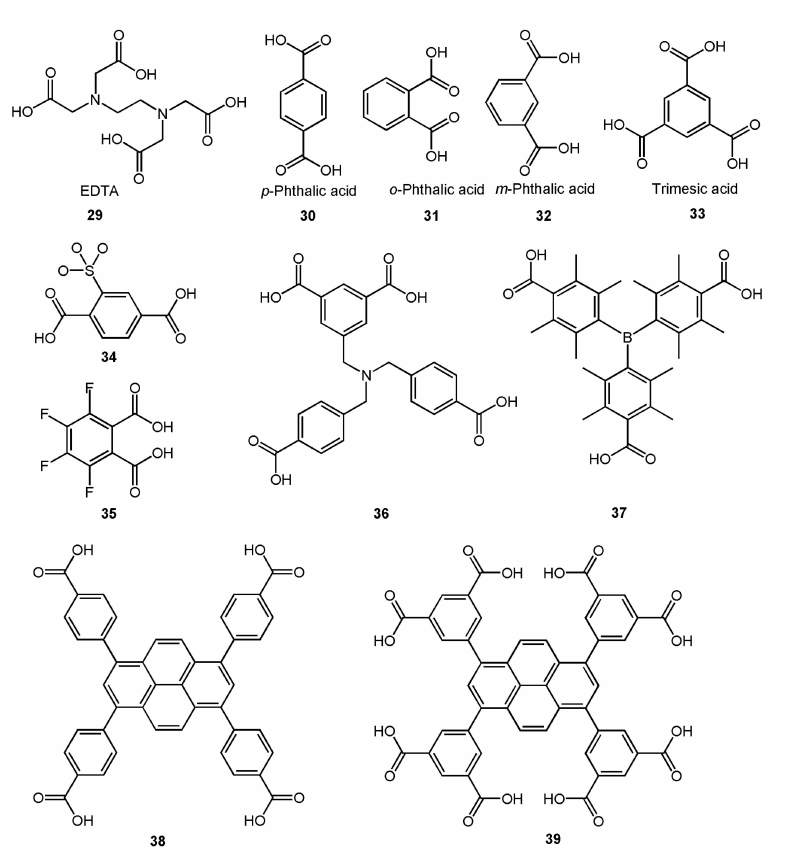
Figure 10. Some polycarboxyl compounds which can be used as bridged ligands mentioned in this chapter.